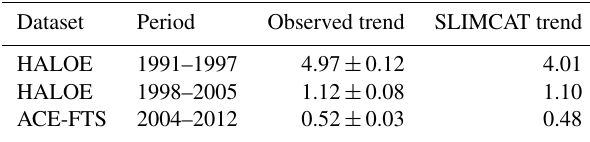
Table 5. Trends (%year − 1 ) derived from the HALOE v19 and ACE-FTS v3.0/v3.5 HF